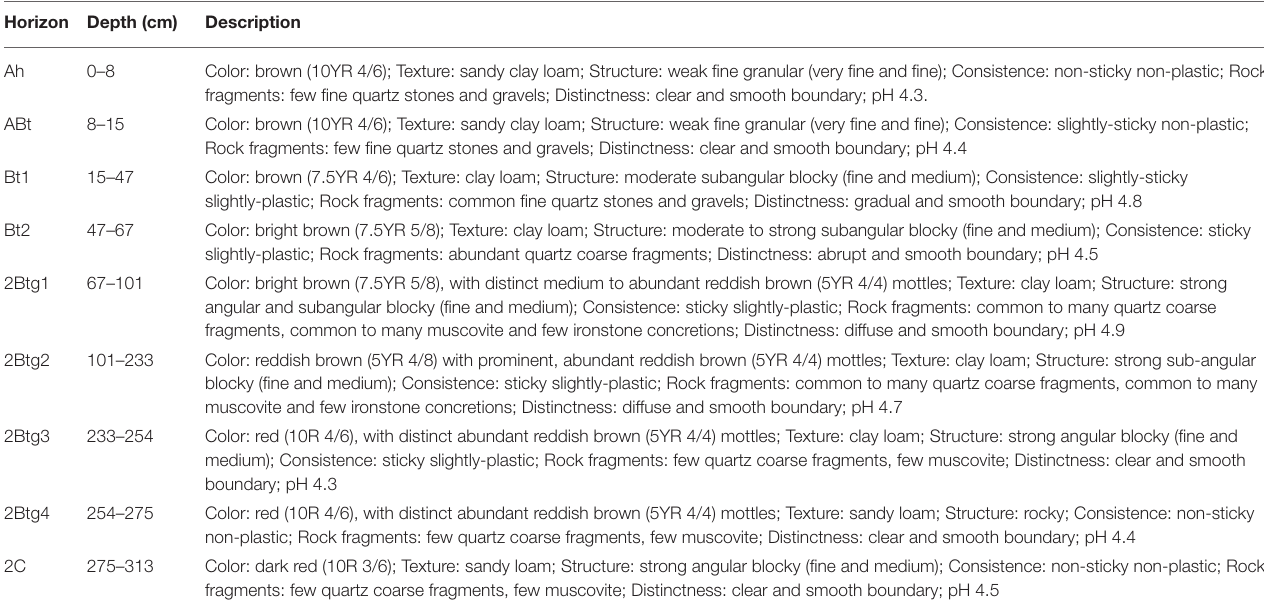
TABLE 1 | Description of the soil profile KS Profile